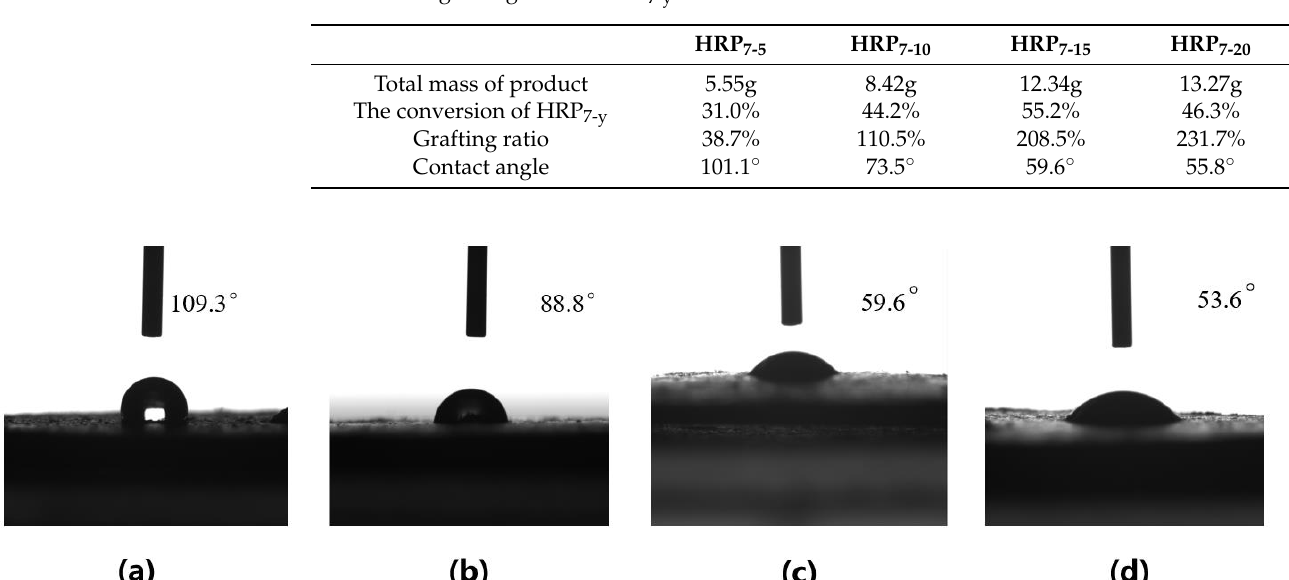
Figure 4. Contact angle of HRP 3-15 ( a ), HRP 5-15 ( b ), HRP 7-15 ( c ), HRP 9-15 ( d ). Table 2. The grafting ratio of HRP x-15 with different amounts of BPO.